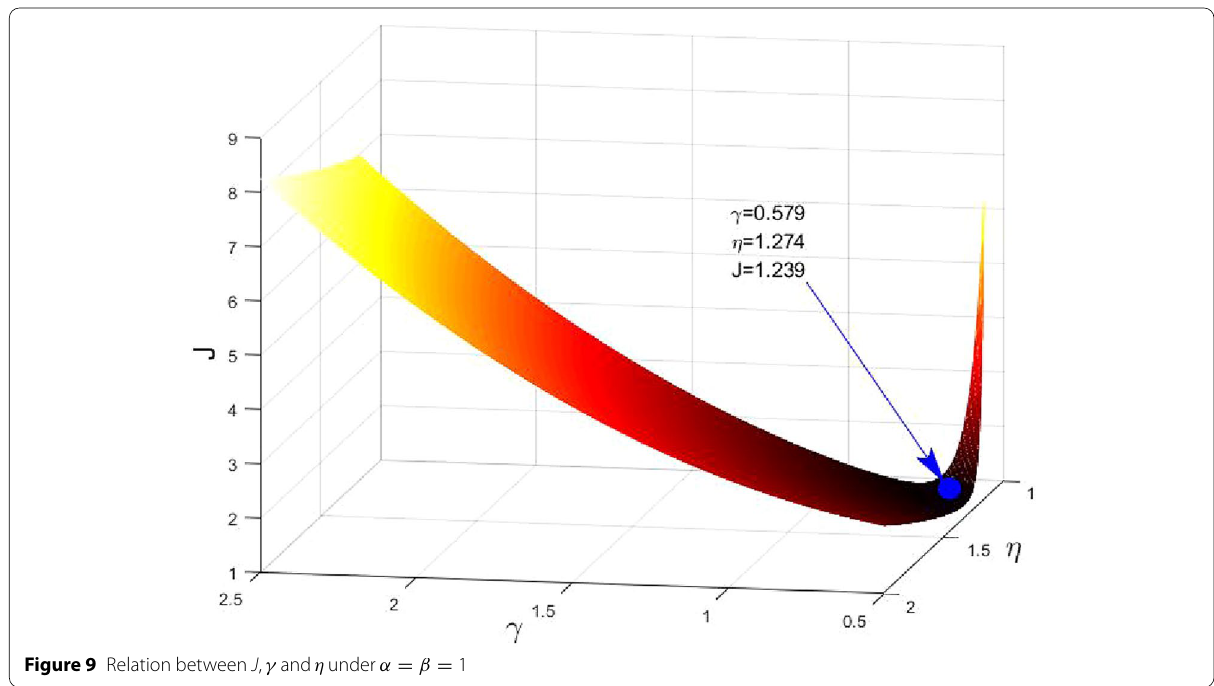
Figure 9 Relation between J , γ and η under α = β = 1